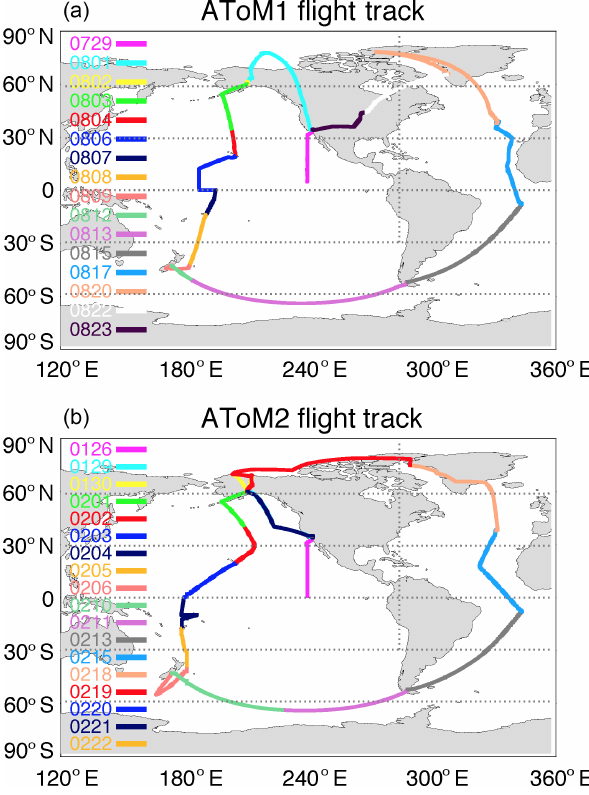
Figure 1. AToM1 (a) and AToM2 (b) flight tracks sorted out for each flight